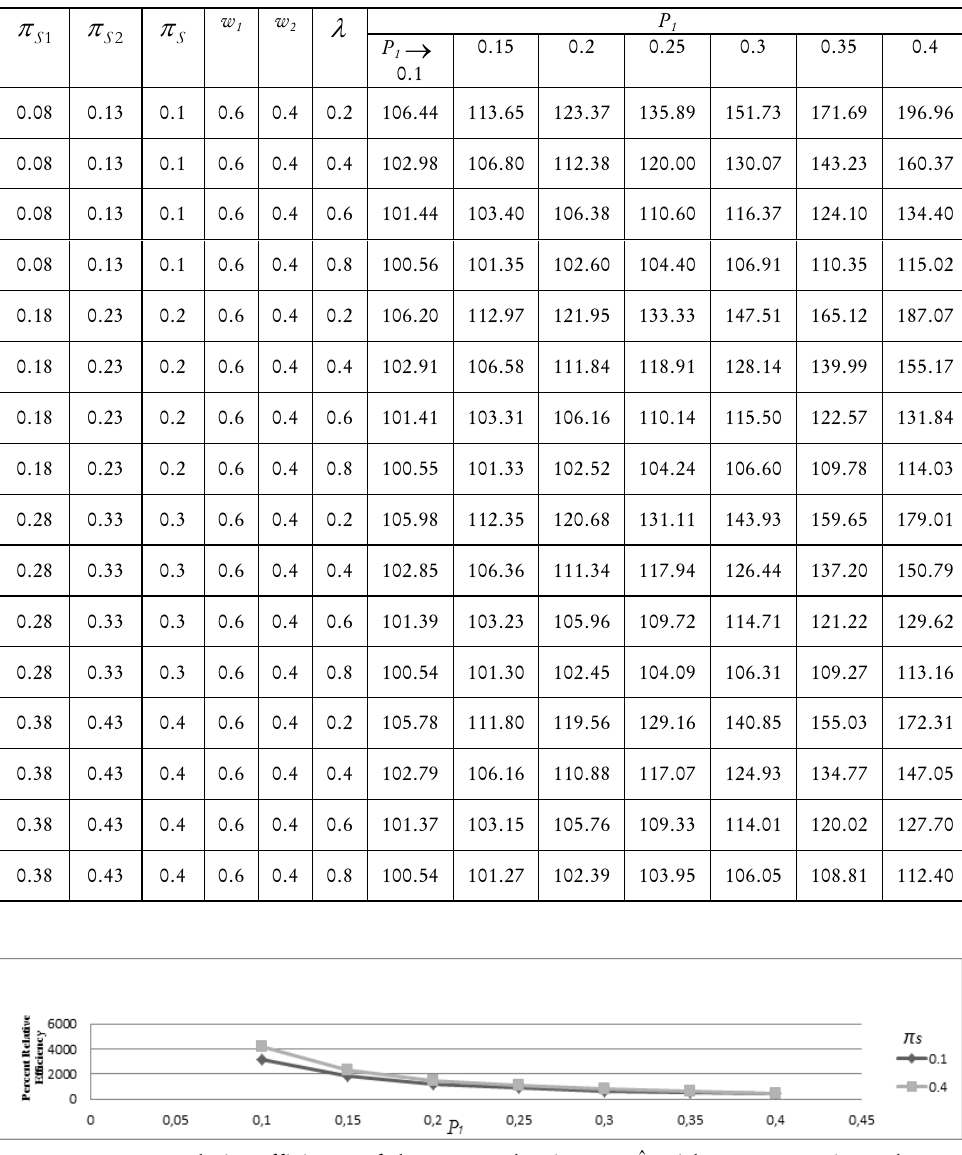
Figure 1 - Percent relative efficiency of the proposed estimator ˆ Warde’s (2005) estimator ˆ